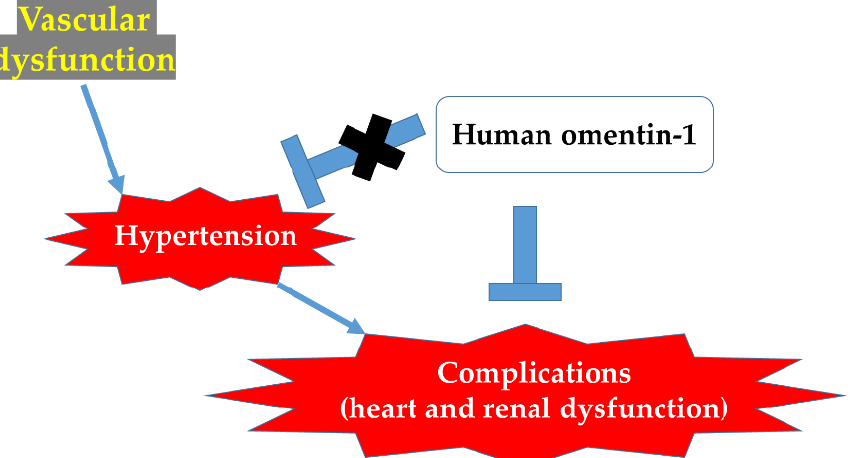
Figure 7. Human omentin-1 tended to improve the hypertension-associated complications (heart and renal dysfunction) in SHR without affecting hypertension.